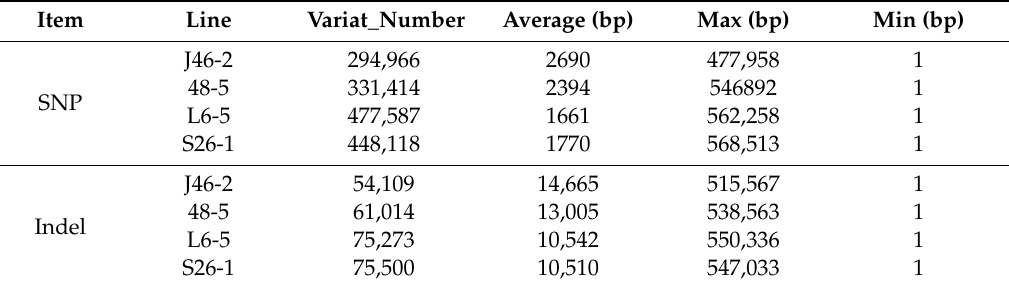
Table 3. Genome-wide analysis of the SNPs (Single Nucleotide Polymorphisms) and indels’ numbers between the wild type and four ethyl methanesulfonate-induced eggplant mutants.